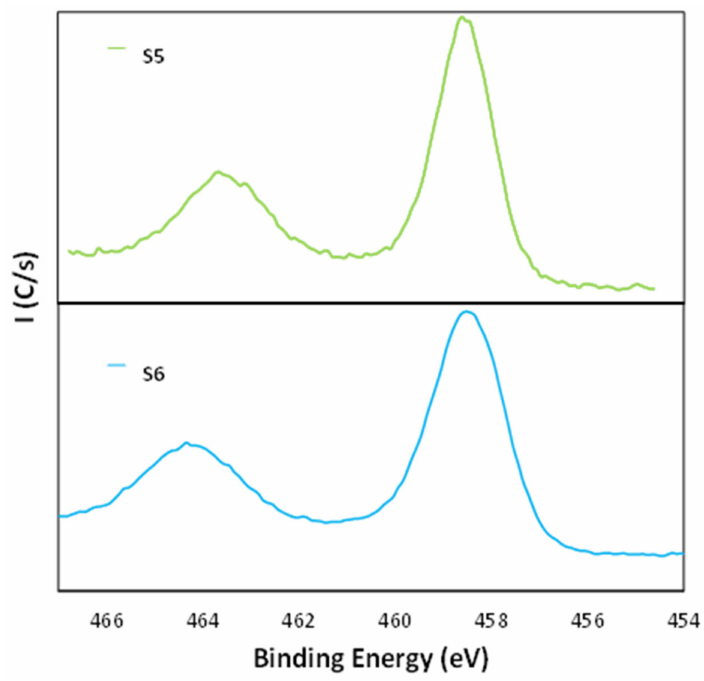
Figure 6. Ti2p core level XPS spectra for the samples S5 and